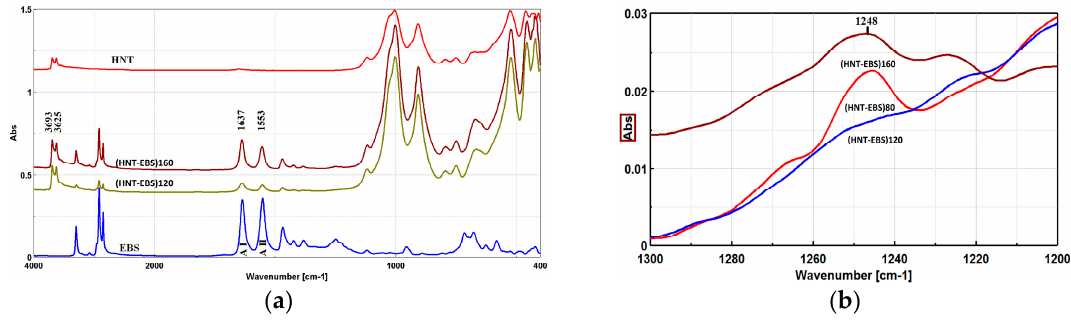
Figure 8. FTIR-ATR spectra of ( a ) HNT-EBS composites; ( b ) band at “1248 cm − 1 ”.